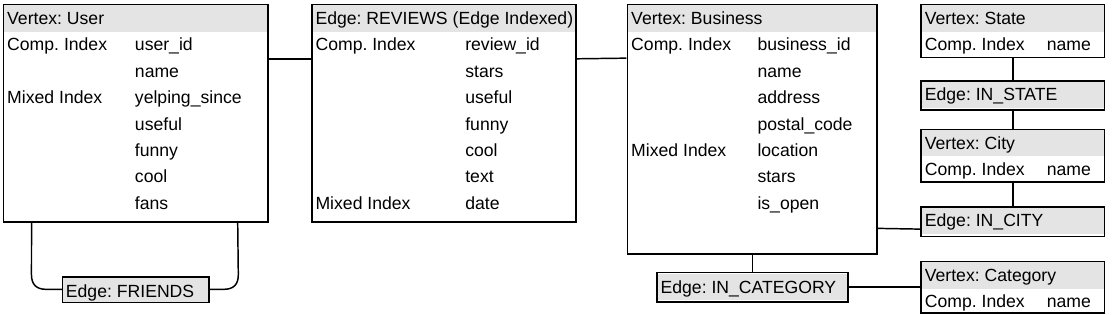
Figure A2. A UML diagram of the graph design of the Yelp dataset in